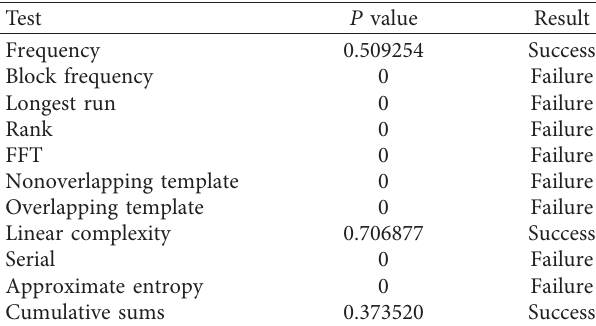
Table 3: Pseudorandom properties of hyperchaotic system.